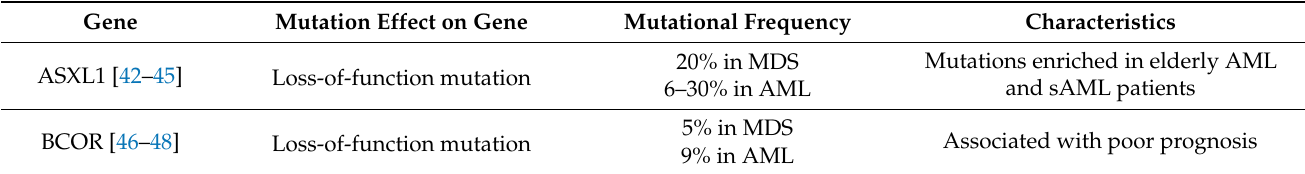
Table 1. Mutations in epigenetic regulators in MDS and